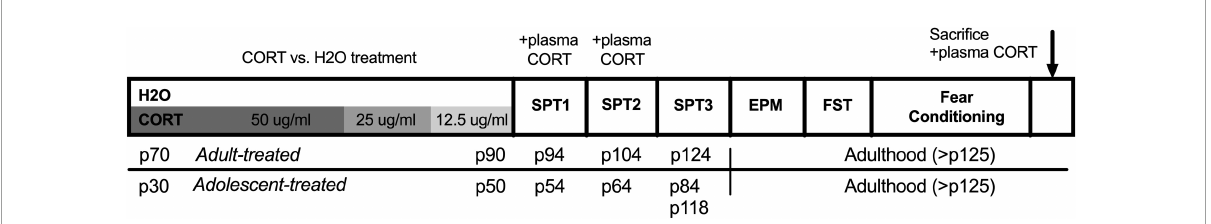
FIGURE1 Timeline of experimental procedures for Experiment 1. Adult-treated rats exposed to either CORT or H 2 O as their sole source of fluid in adulthood (p70–90), while adolescent-treated rats were exposed in adolescence (p30–50). All behavioral testing was conducted in adulthood, with the exception of the first two sucrose preference tests in adolescent-exposed rats that took place in the transition from late adolescence to early adulthood. CORT, corticosterone; H 2 O, water; p, postnatal day; SPT, sucrose preference test; EPM, elevated plus maze; FST, forced swim